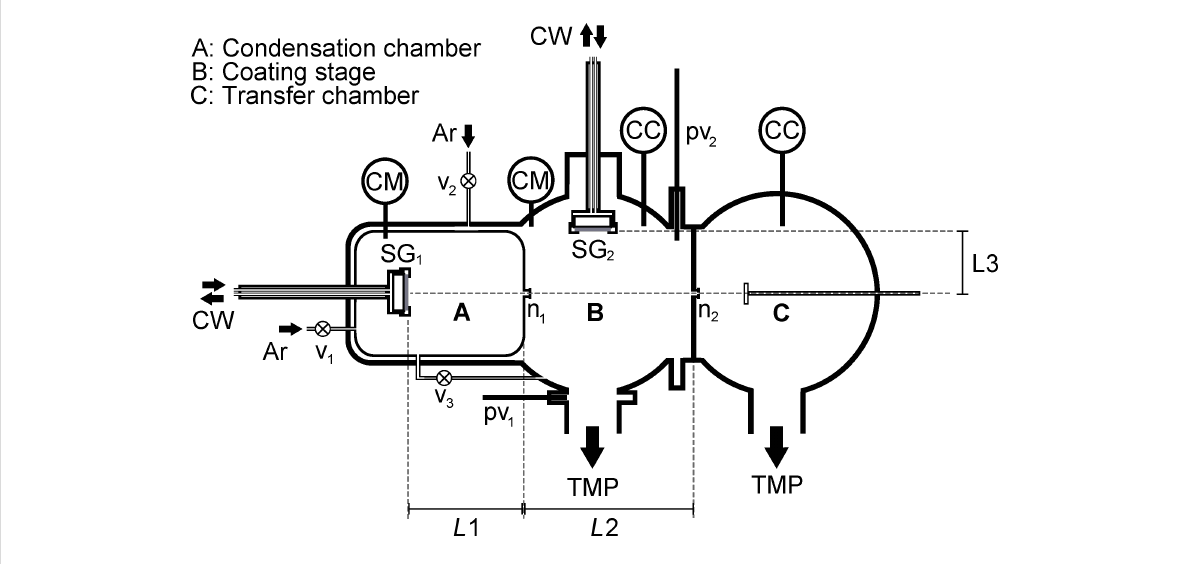
Figure 1: Schematic drawing of the home-built UHV setup used in the present study. CM: capacitance manometers, CC: cold cathode, TMP: turbo molecular pump, CW: cooling water, v: valve, pv: gate valve, SG: sputter gun, n: nozzle.